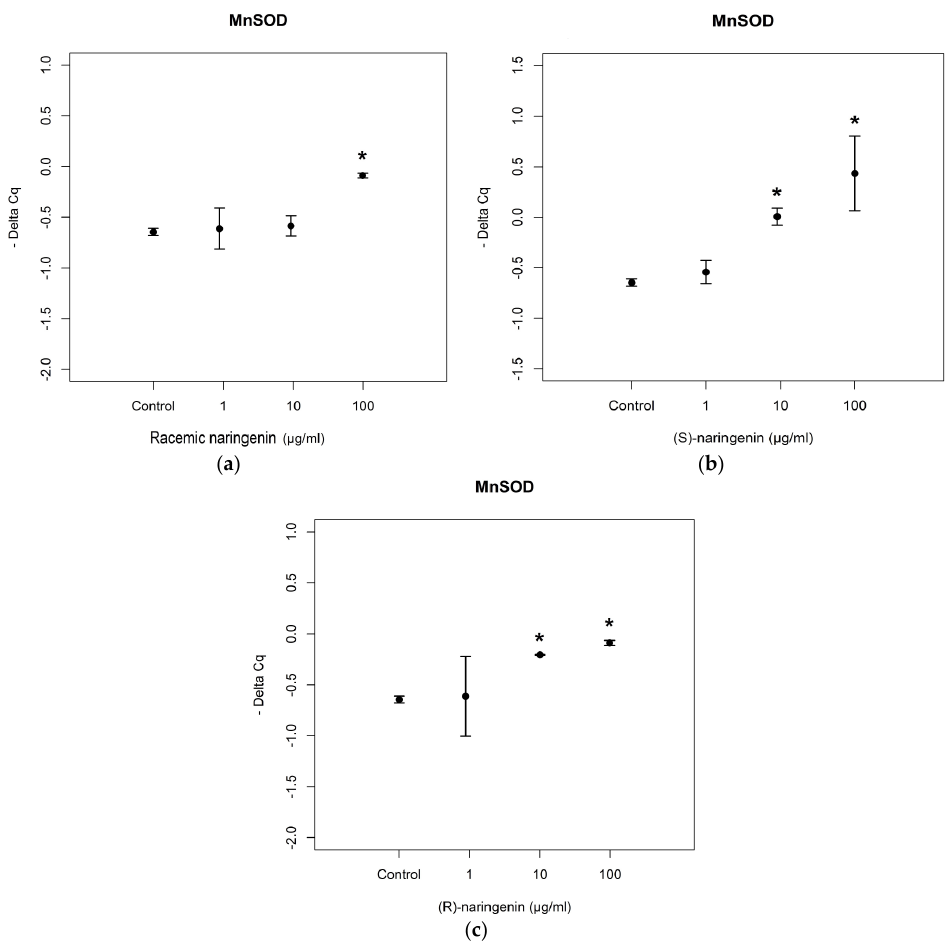
Figure 3. Expression levels, reported as Delta Cq, of mRNA coding for MnSOD in Caco ‐ 2 cells treated with increasing concentrations of ( a ) racemic naringenin, ( b ) ( S ), and ( c ) ( R ) naringenin (1–100 μ g/mL). * Indicates statistically significant differences between treated and untreated cell cultures, as reported in the text.